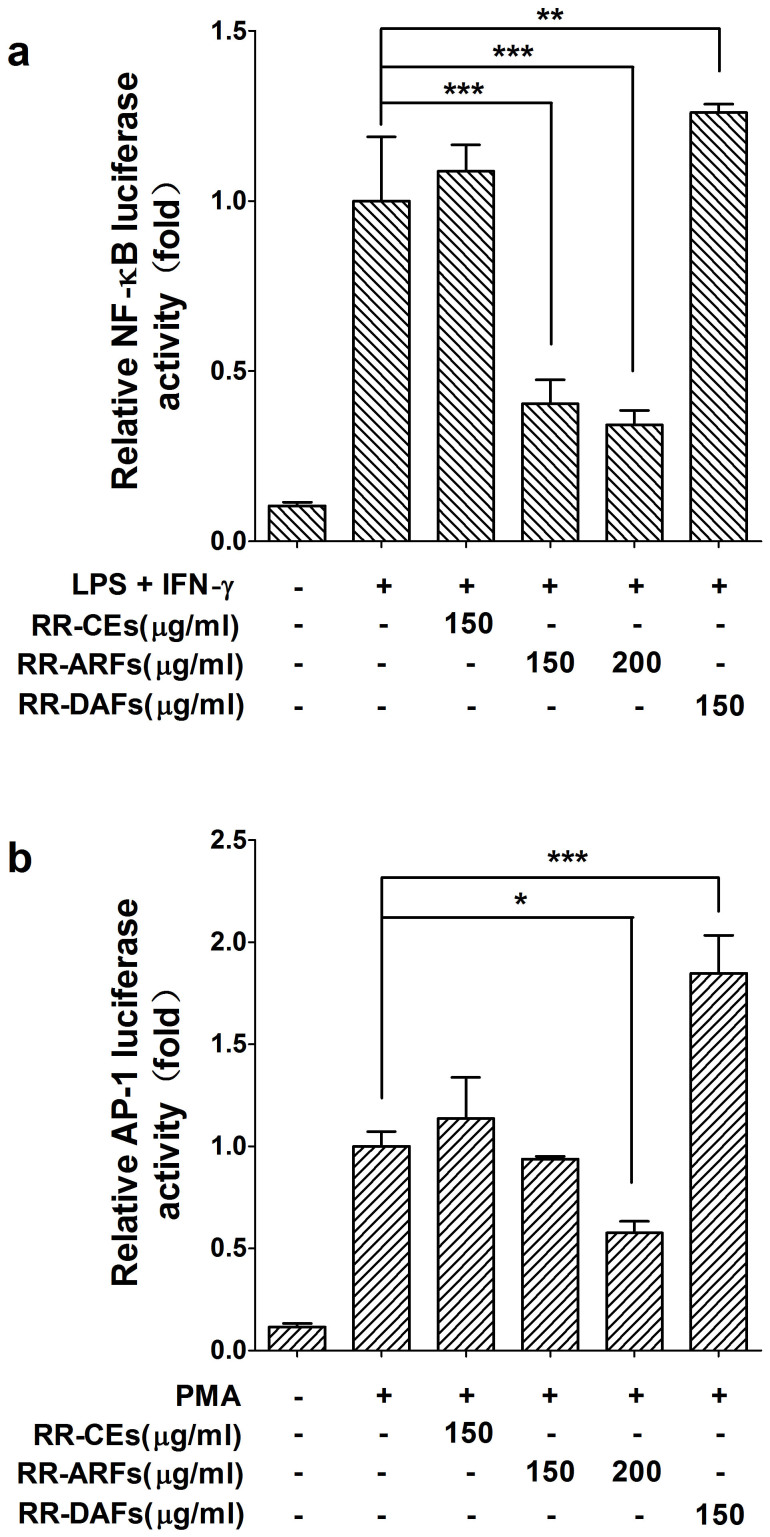
NF-κB and AP-1 pathway luciferase reporter assays.RAW264.7 cells were transiently co-transfected with pNFκB-Luc (a) or pAP1-Luc (b) and pRL-TK using Lipofectamine™ 2000 Transfection Reagent. Cells were then treated with different extracts from RR and LPS/IFN-γ or PMA. After 24 h culture, cells were collected for dual-luciferase activity assays. Each value represents the mean ± SD of three independent experiments, and * P < 0.05, ** P < 0.01, *** P < 0.001 compared to LPS/IFN-γ control.